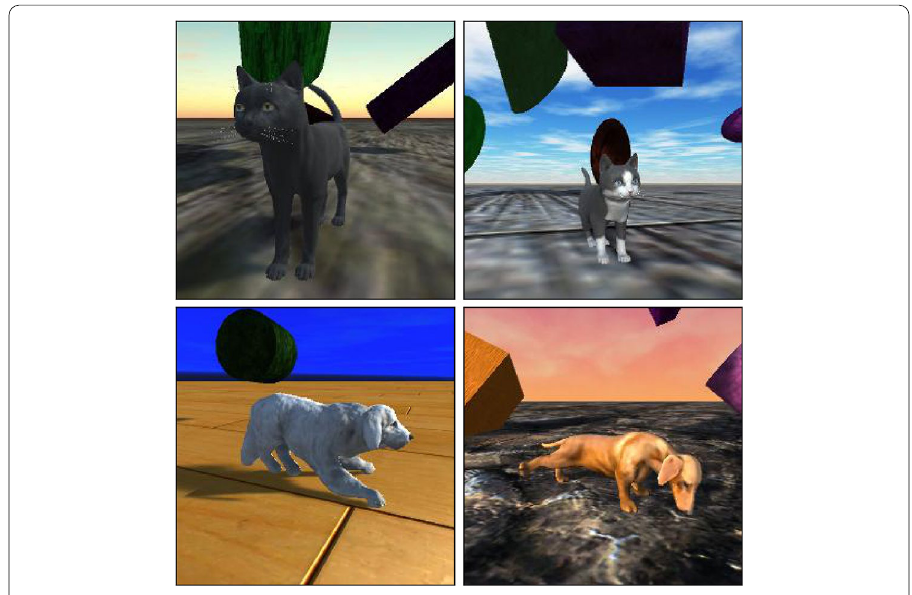
Fig. 1 Examples of synthetic data generated using domain randomization of cats and dogs. Materials, breeds, skyboxes, camera, lighting, pose and obstructors are randomized across